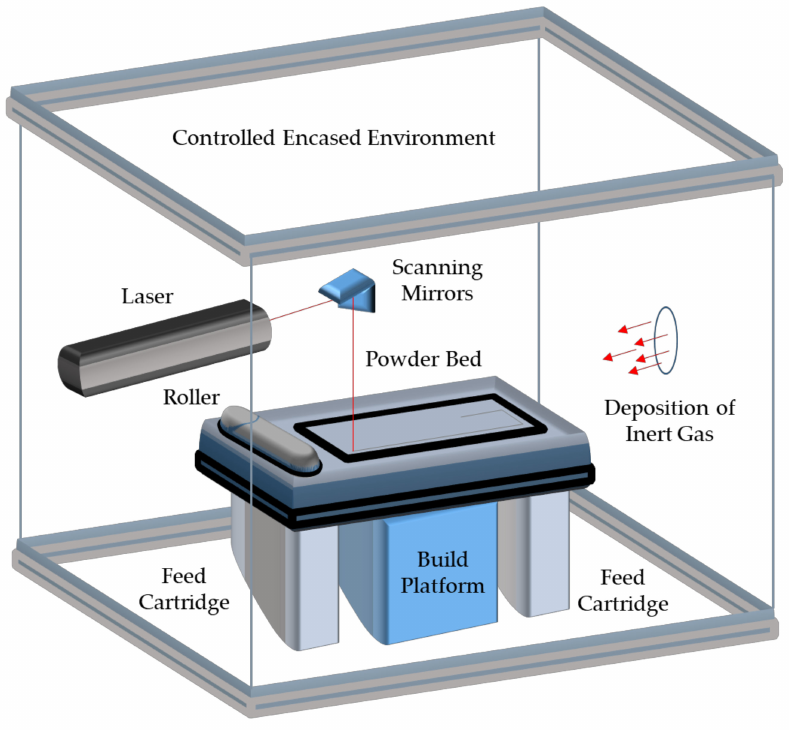
Figure 1. A schematic of a general powder bed fusion system, adapted with the permission of Ralls et al.